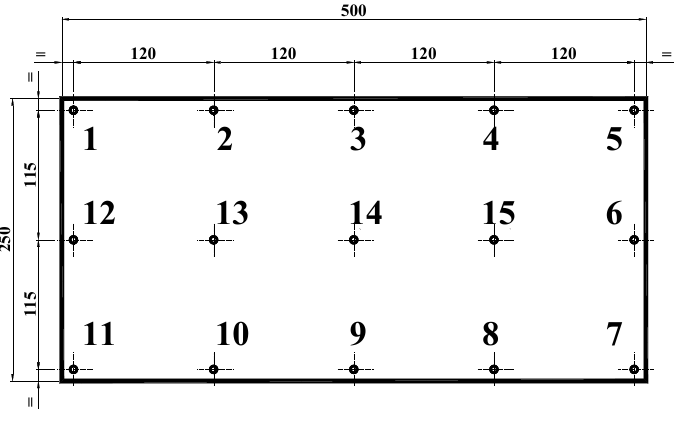
Figure 2. The 15 measuring points of deflection.